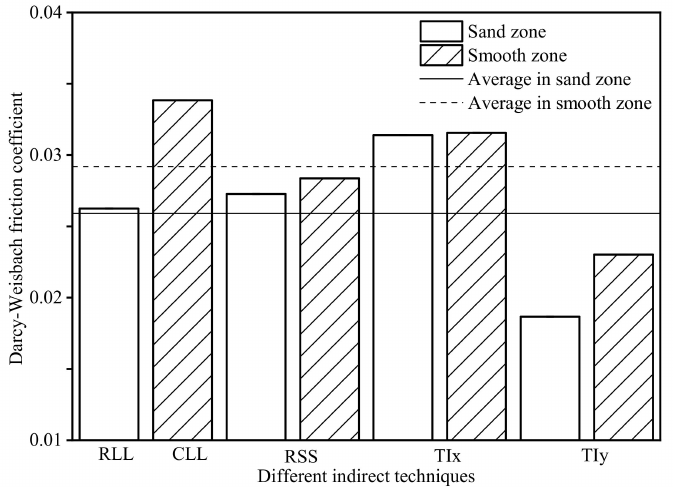
Figure 13. The Darcy–Weisbach friction coefficient estimated by different indirect methods in the sand zone and smooth